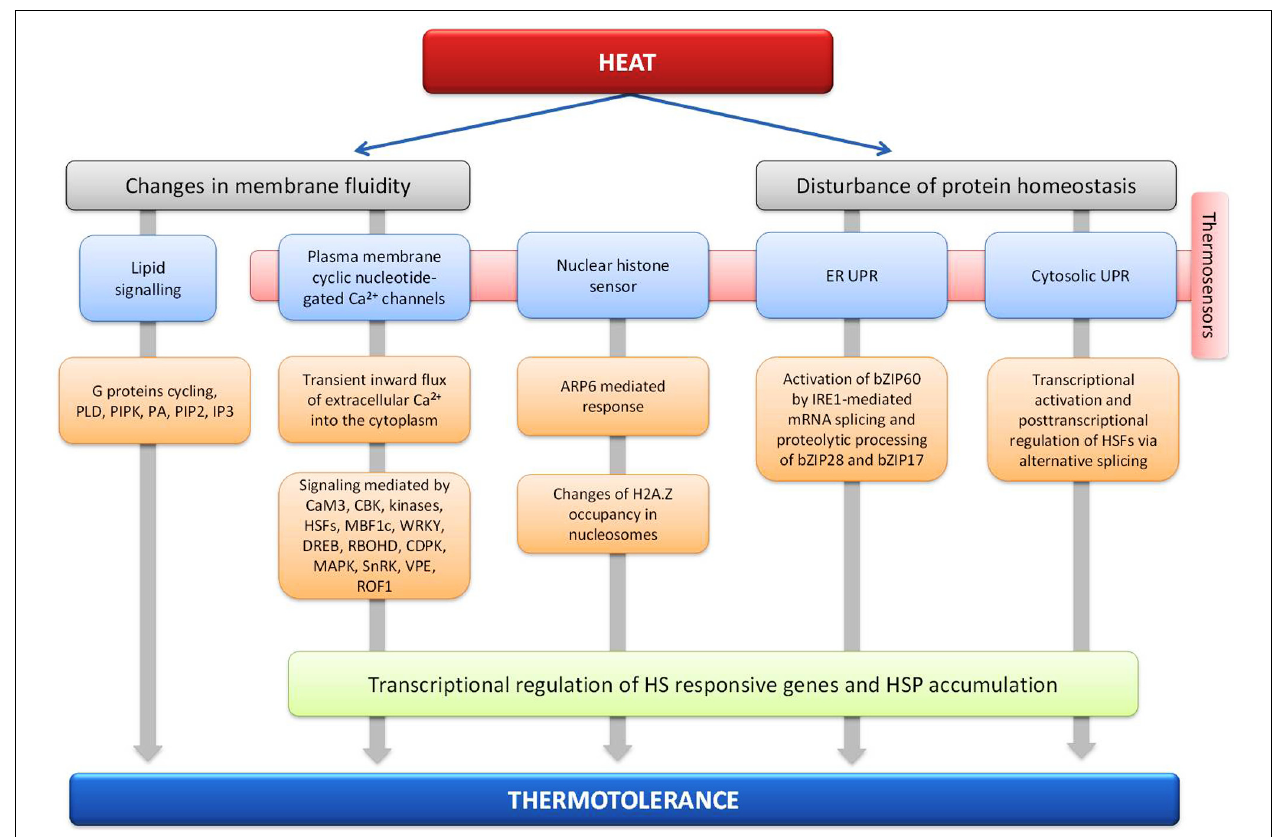
FIGURE 1 | Plant thermosensors and main signal transduction pathways implicated in heat stress response and